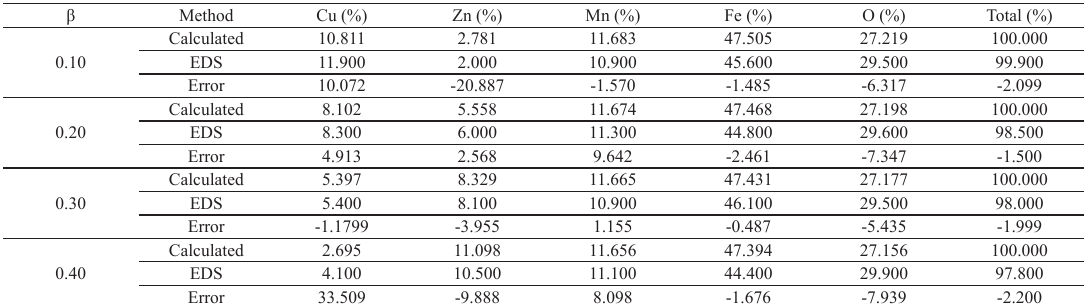
Table 6. Comparison between the theoretical stoichiometric calculations and the experimental results obtained by the EDS analysis. β